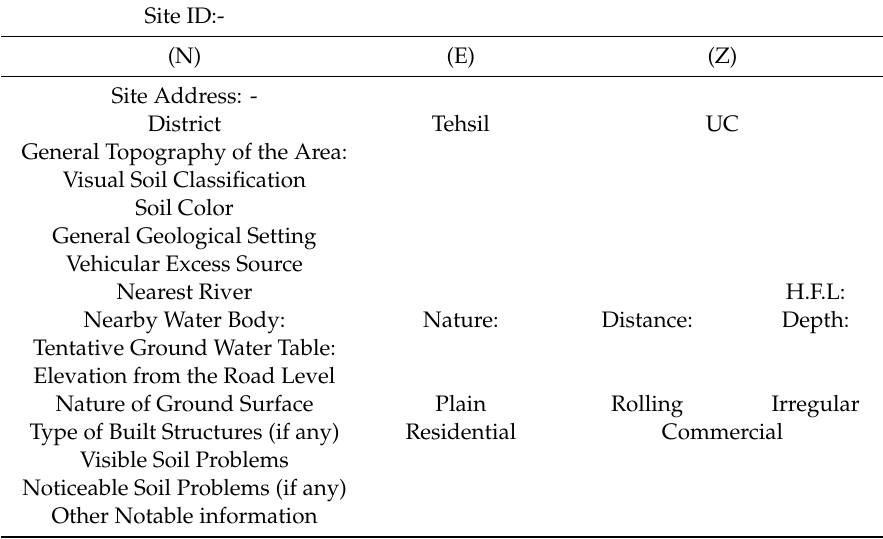
Table 1. Reconnaissance Survey Information